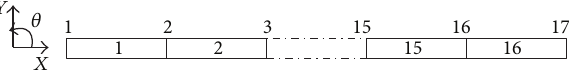
Figure 3: Discretized steel beam.